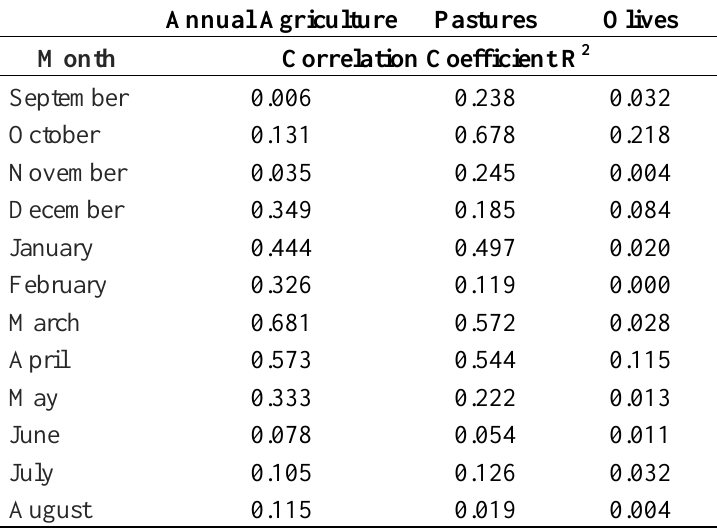
Table 1. VAI to CP precipitation correlation coefficients, computed for each month, for 3 annual agriculture, pastures and olive groves.